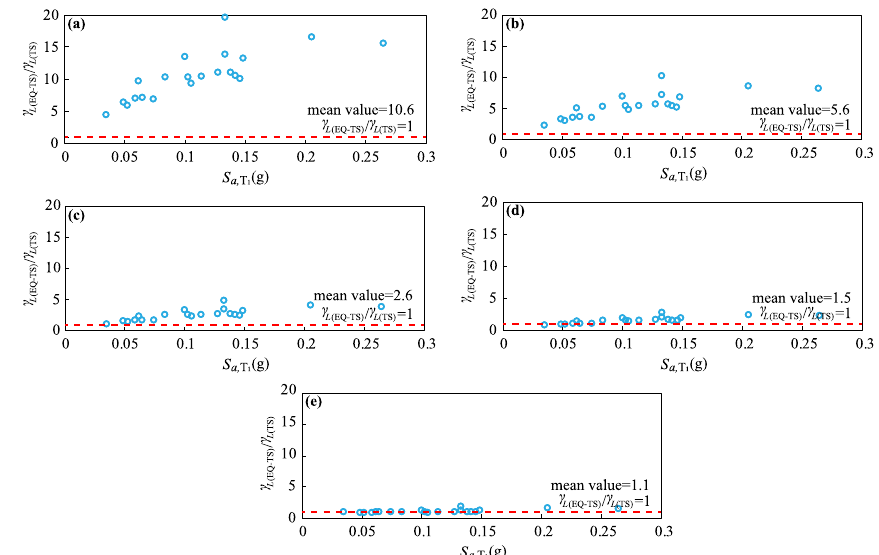
Fig. 10 Ratio of longitudinal bearing shear strain with respect to the S a , T b 6 m, c 7 m, d 8 m and e 9